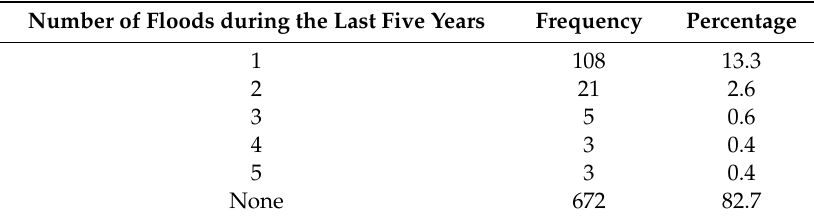
Table 3. Floods during the last five years.